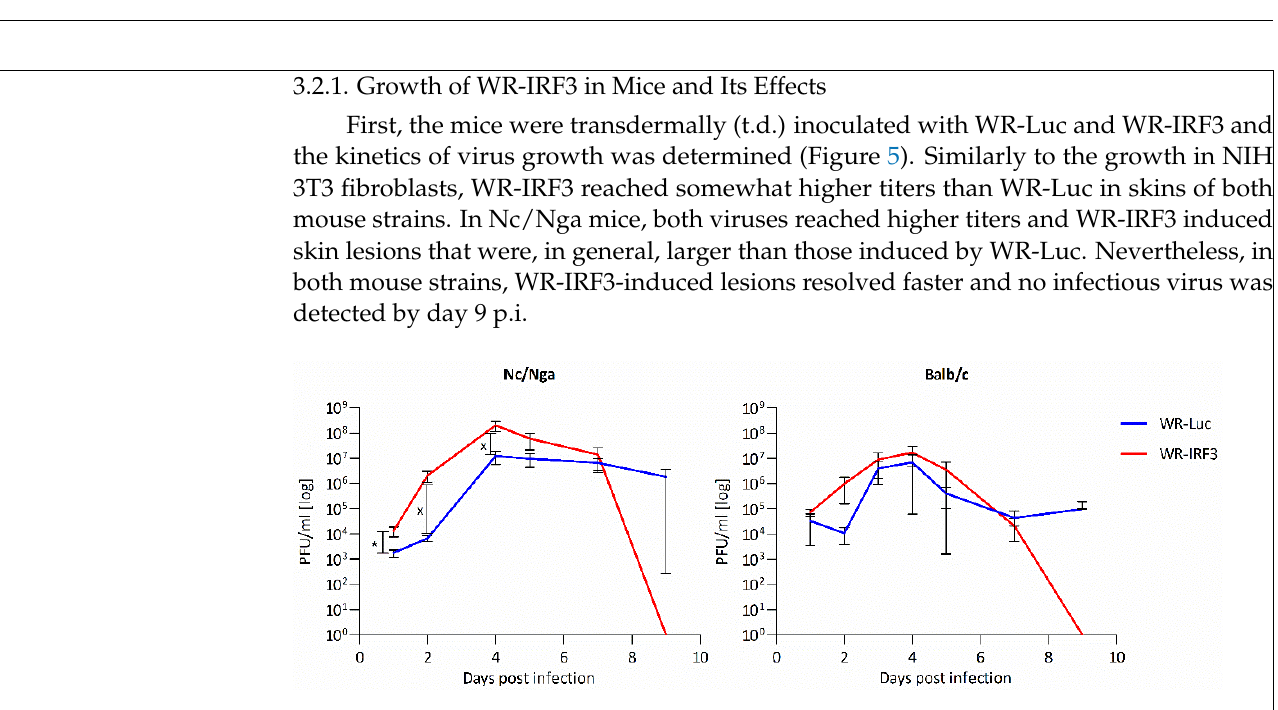
Figure 5. Growth of WR-IRF3 is increased in mouse skin lesions. Nc/Nga and Balb/c mice were transdermally inoculated transdermally inoculated with 10 4 PFU of a purified stock of WR-Luc or WR-IRF3 and sacrificed at with 10 4 PFU of a purified stock of WR-Luc or WR-IRF3 and sacrificed at indicated days p.i. Skin biopsies were taken and indicated days p.i. Skin biopsies were taken and virus titers (PFU/mL) in the lesions were deter- virus titers (PFU/mL) in the lesions were determined. Graphs represent mean +/- S.E.M., n = 3 mice/group. Statistically mined. Graphs represent mean +/ − S.E.M., n = 3 mice/group. Statistically significant differences significant differences at * p < 0.05, x p < 0.1 (one-tailed unpaired Student’s t-test). WR-Luc, mice infected with VACV expressing luciferase; WR-IRF3, mice infected with VACV expressing Mu IRF-3.